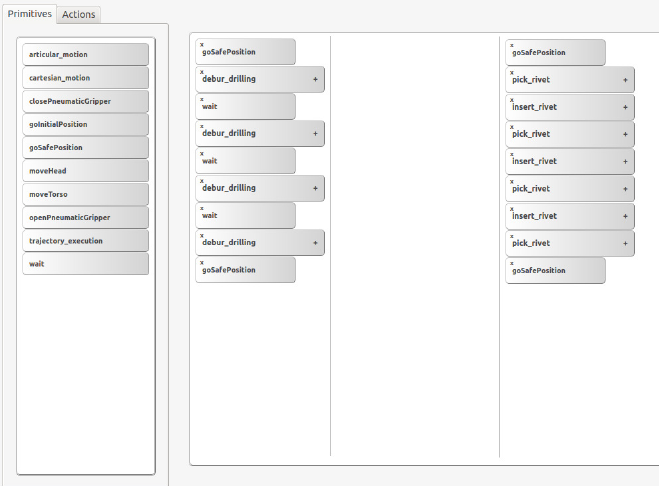
Figure 7. Simple GUI for new application